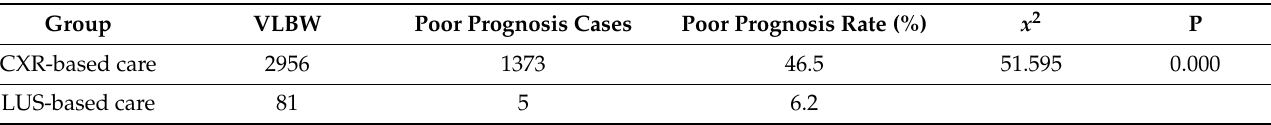
Table 5. The influence of LUS-based care on prognosis of VLBW infants.